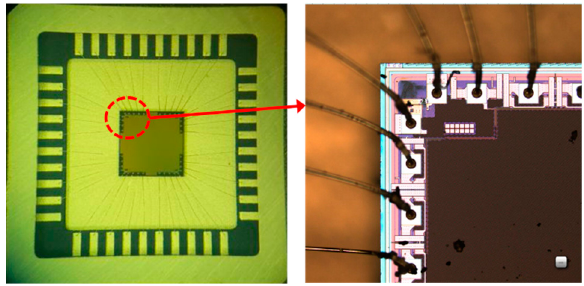
Figure 4. Amplifier chip in low-profile quad flat package (LQFP) package.